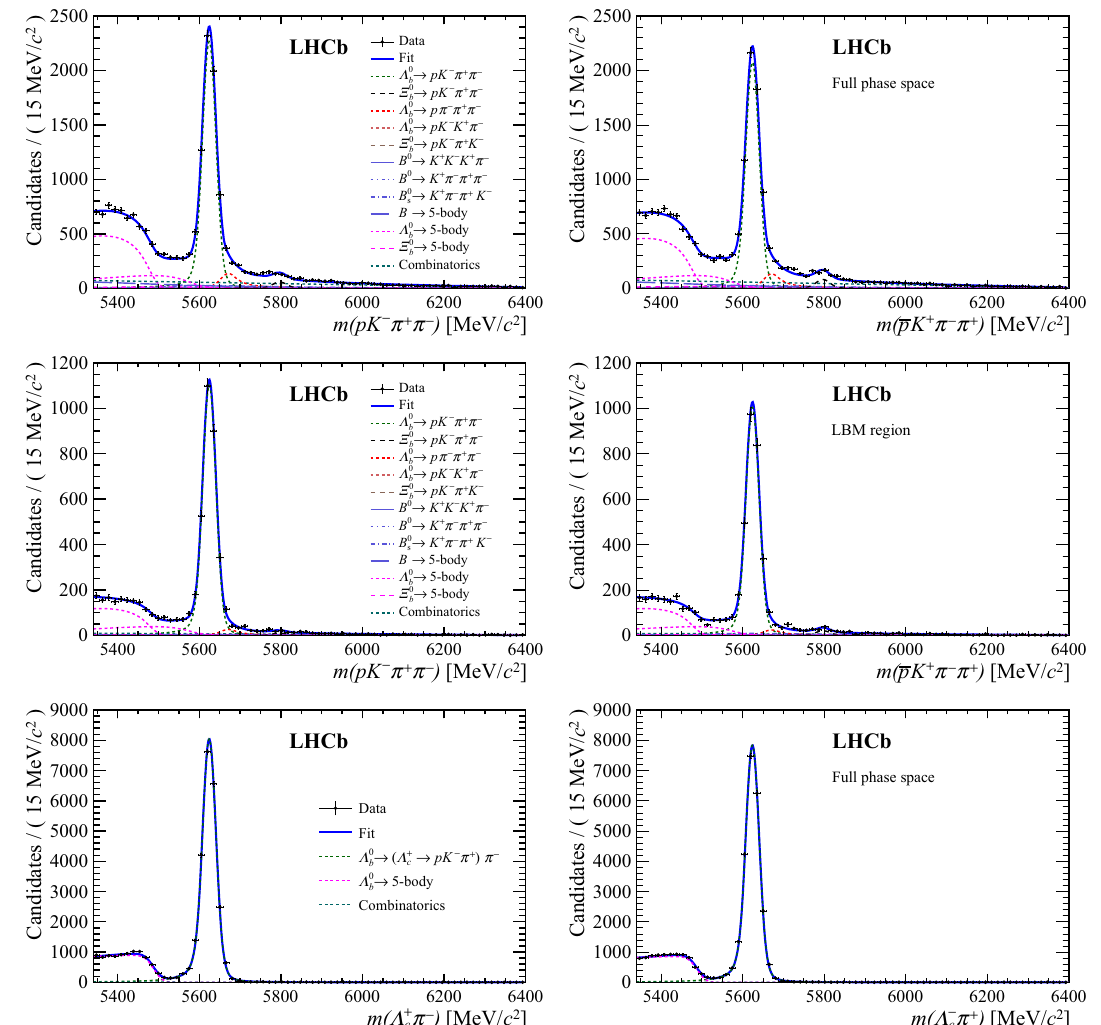
→ five-body legend includes two b → pK − η (cid:4) and Λ 0 → b b